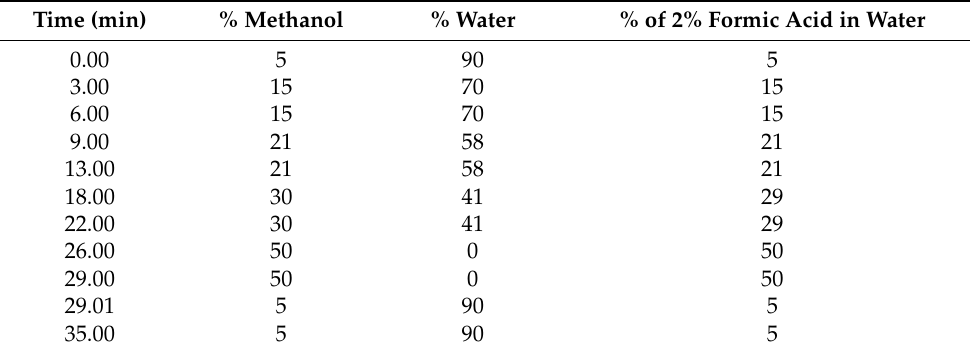
Table 8. Composition of the LC–MS mobile phase